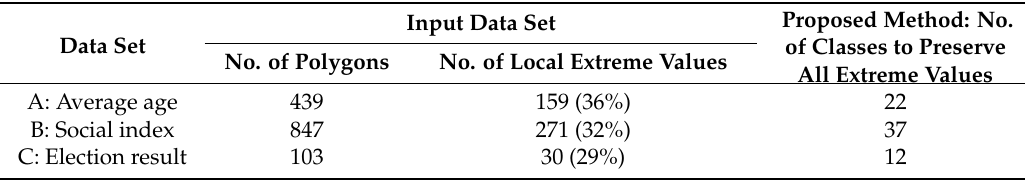
Table 7. Data sets for empirical tests. Table 7 Data sets for empirical tests.